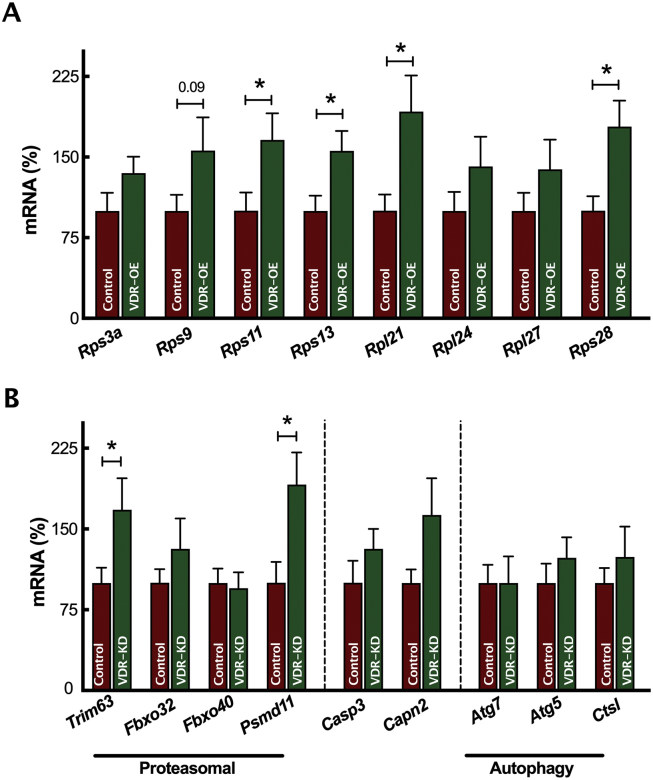
In vivo VDR-OE enhances ribosomal biogenesis. qRT-PCR measurement of (A) ribosomal and (B) proteolytic related gene expression (n = 7). Data are mean ± SEM. ∗p < 0.05 between indicated groups.